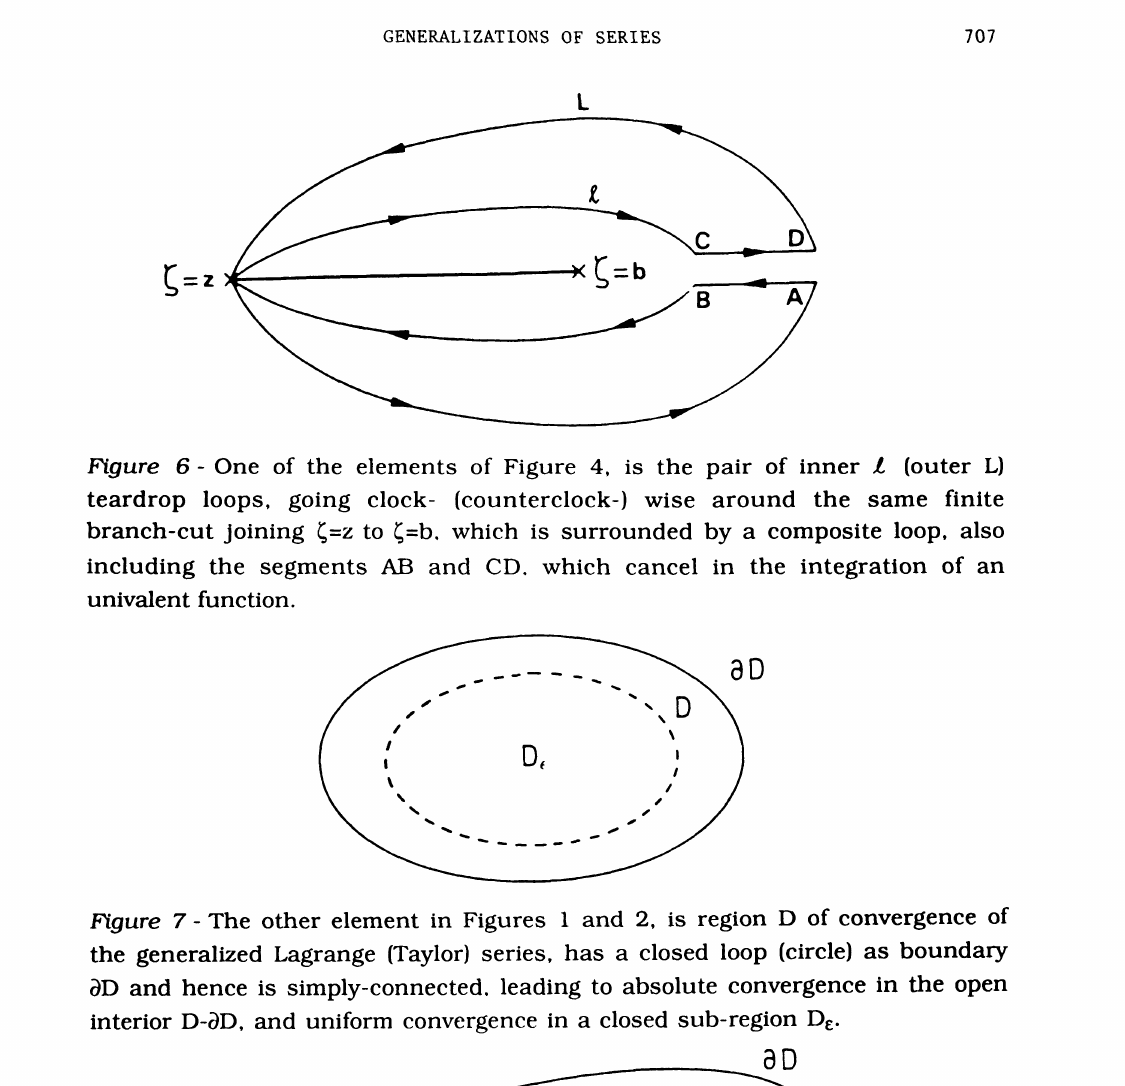
Figure 7- The other element in Figures 1 and 2, is region D of convergence of the generalized Lagrange (Taylor) series, has a closed loop (circle) as boundary D and hence is simply-connected, leading to absolute convergence in the open interior D-)D, and uniform convergence in a closed sub-region De.